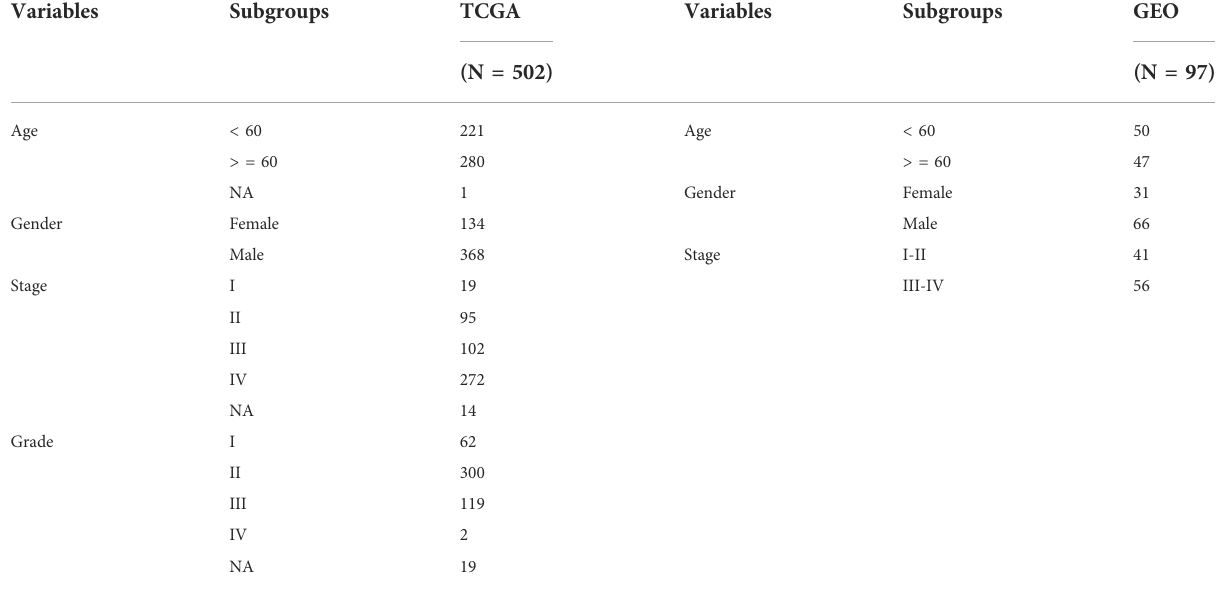
TABLE 1 Clinical data of patients in the TCGA and the GEO validation